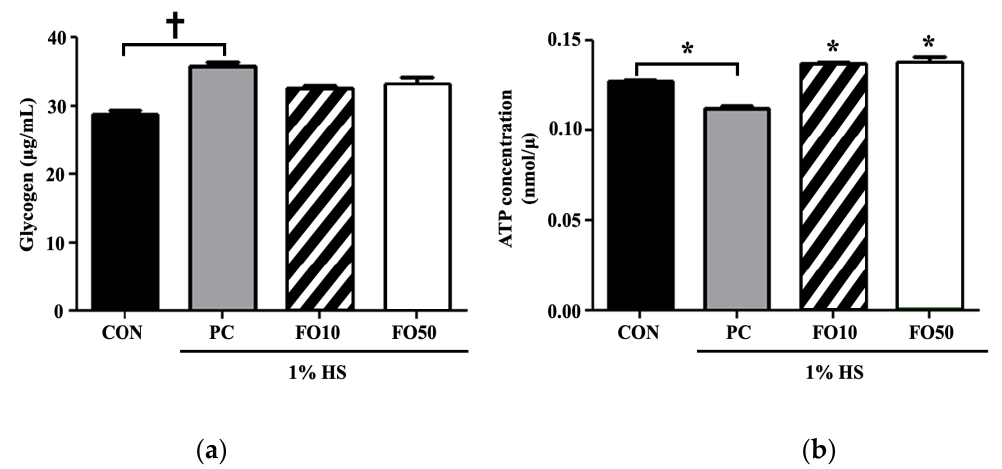
Figure 5. Changes in ( a ) glycogen and ( b ) Adenosine triphosphate (ATP) levels were determined in C2C12 muscle cells following administration of 10 and 50 μg/mL of FO. Each bar represents the mean ± SD. A one-way ANOVA test was used to determine significant differences (* p < 0.05 vs. positive control, † p < 0.001 vs. positive control).